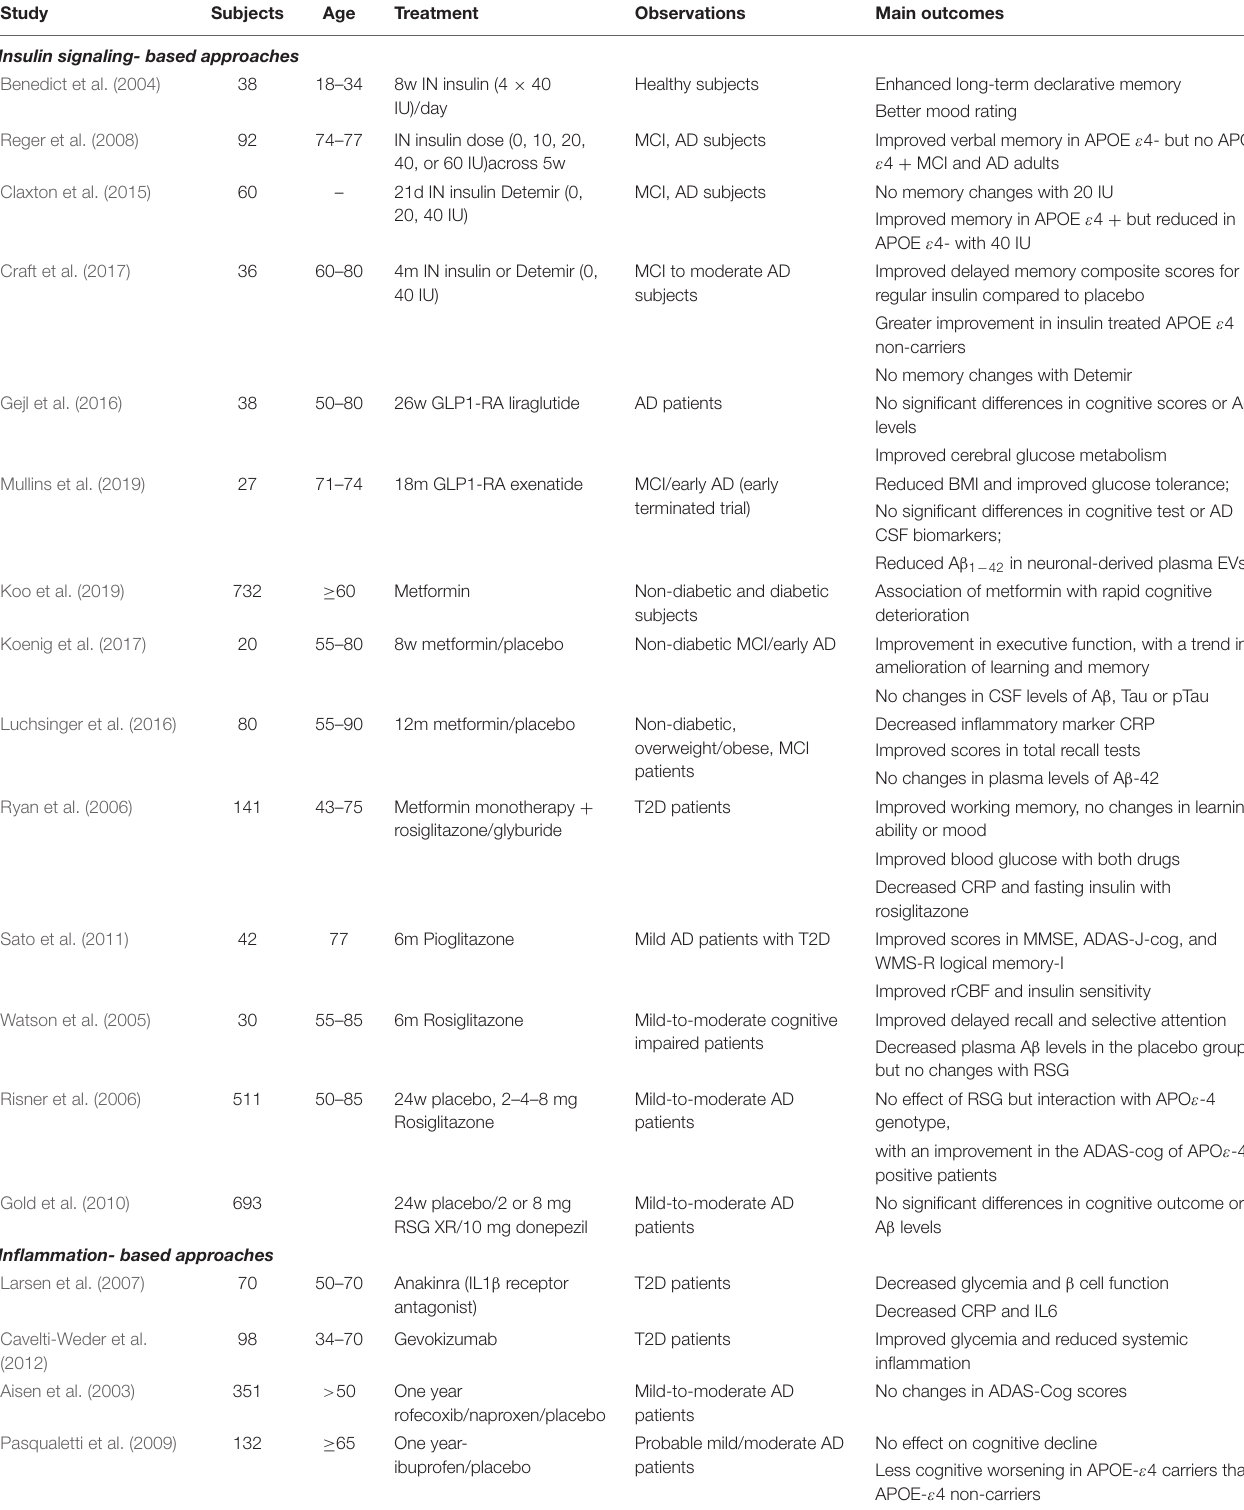
TABLE 1 | Clinical trials targeting insulin resistance and/or inflammation for the treatment of cognitive impairment and